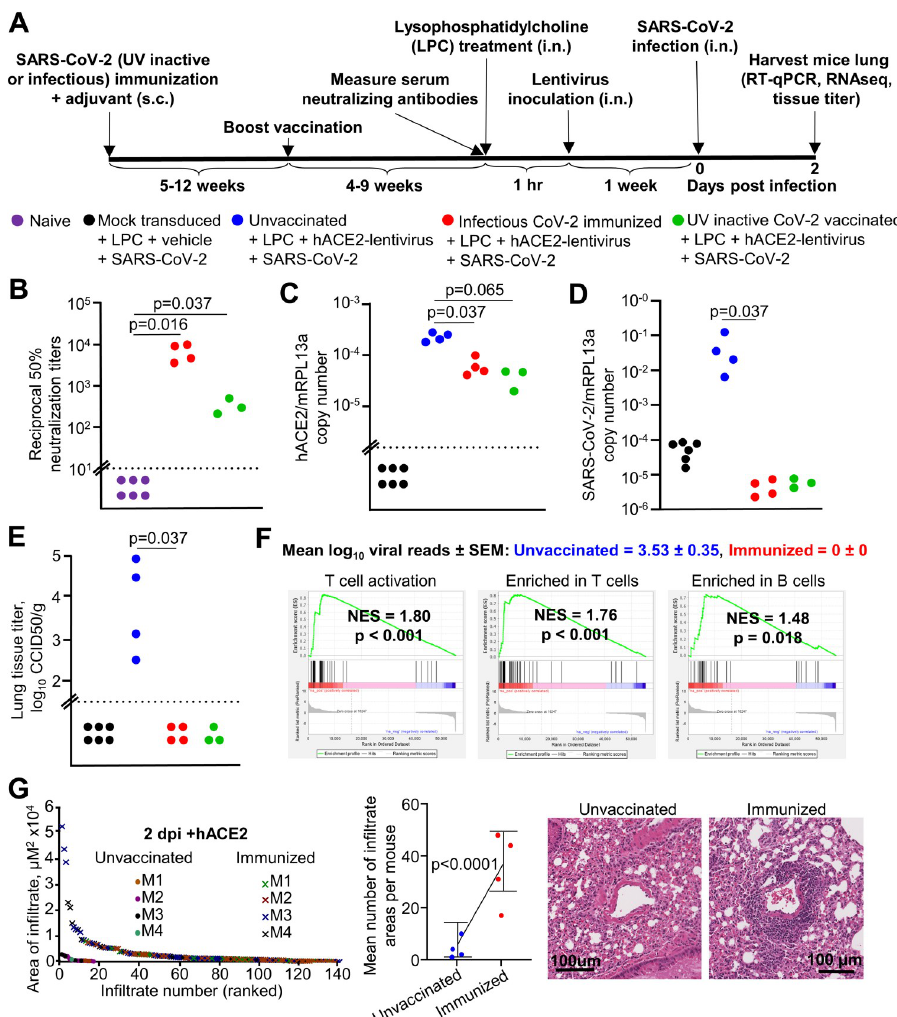
Fig 7. Immunization with infectious or UV-inactivated SARS-CoV-2 protects against virus infection. A) Timeline of mice immunization, lentivirus transduction and SARS-CoV-2 infection. Mock transduced mice, n = 6 (data from Fig 2). Unvaccinated C57BL/6J mice, n = 4 (data from Fig 2). Infectious CoV-2 immunized mice, n = 4. UV inactive CoV-2 vaccinated, n = 3 mice. B) Reciprocal 50% neutralization titers of na ï ve mice and infectious or UV SARS-CoV- 2 immunized mice. Horizontal dotted line represents the limit of detection (1 in 10). Statistics are by Kolmogorov Smirnov test. C) RT-qPCR of mouse lung RNA using primers for hACE2 introduced by lentivirus transduction normalized to mRPL13a levels. Data is individual mice and is expressed as RNA copy number calculated against a standard curve for each gene. Horizontal line indicates cut-off for reliable detection, with all hACE2-negative mice falling below this line. Statistics are by Kolmogorov Smirnov test. D) RT-qPCR of mouse lungs RNA using primers for SARS-CoV-2 E gene normalized to mRPL13a levels. Data is for individual mice and is expressed as RNA copy number calculated against a standard curve for each gene. Statistics are by Kolmogorov Smirnov test. Unvaccinated versus UV- inactive CoV-2 vaccinated reaches significance by Kruskal-Wallis test (p = 0.034). E) Titer of SARS-CoV-2 in mouse lungs determined using CCID 50 assay of lung homogenate. Horizontal line indicates the limit of detection of 1.57 log 10 CCID 50 /g. Statistics are by Kolmogorov Smirnov test. Unvaccinated versus UV-inactive CoV-2 vaccinated reaches significance by Kruskal-Wallis test (p = 0.028). F) Mean log 10 SARS-CoV-2 read count at day 2 post-infection in RNA- seq data ± SEM is shown (blue text = unvaccinated mice, red text = infectious SARS-CoV-2 immunized mice). GSEA for Blood Transcription Modules (BTMs) from Li et al. [89] against the pre-ranked all gene list comparing unvaccinated versus infectious SARS-CoV-2 immunized (s.c) mouse lung at day 2 (all mice had hACE2-lentivirus transduction). Selected BTM modules with a positive NES score and p < 0.05 are shown (full list in S5 Dataset). See S5 Dataset for full gene and DEG lists and full downstream analyses lists. G) The areas of dense infiltrates (lesions) in lung sections from unvaccinated and immunized mice (n = 4 each group) at day 2 were measured and plotted, ranked largest to smallest lesion (left). Data for ‘unvaccinated’ mice is from ‘Fig 3A’. More and larger lesions were seen in immunized mice compared to unvaccinated mice. Statistics modelled lesion counts with a Poisson generalised